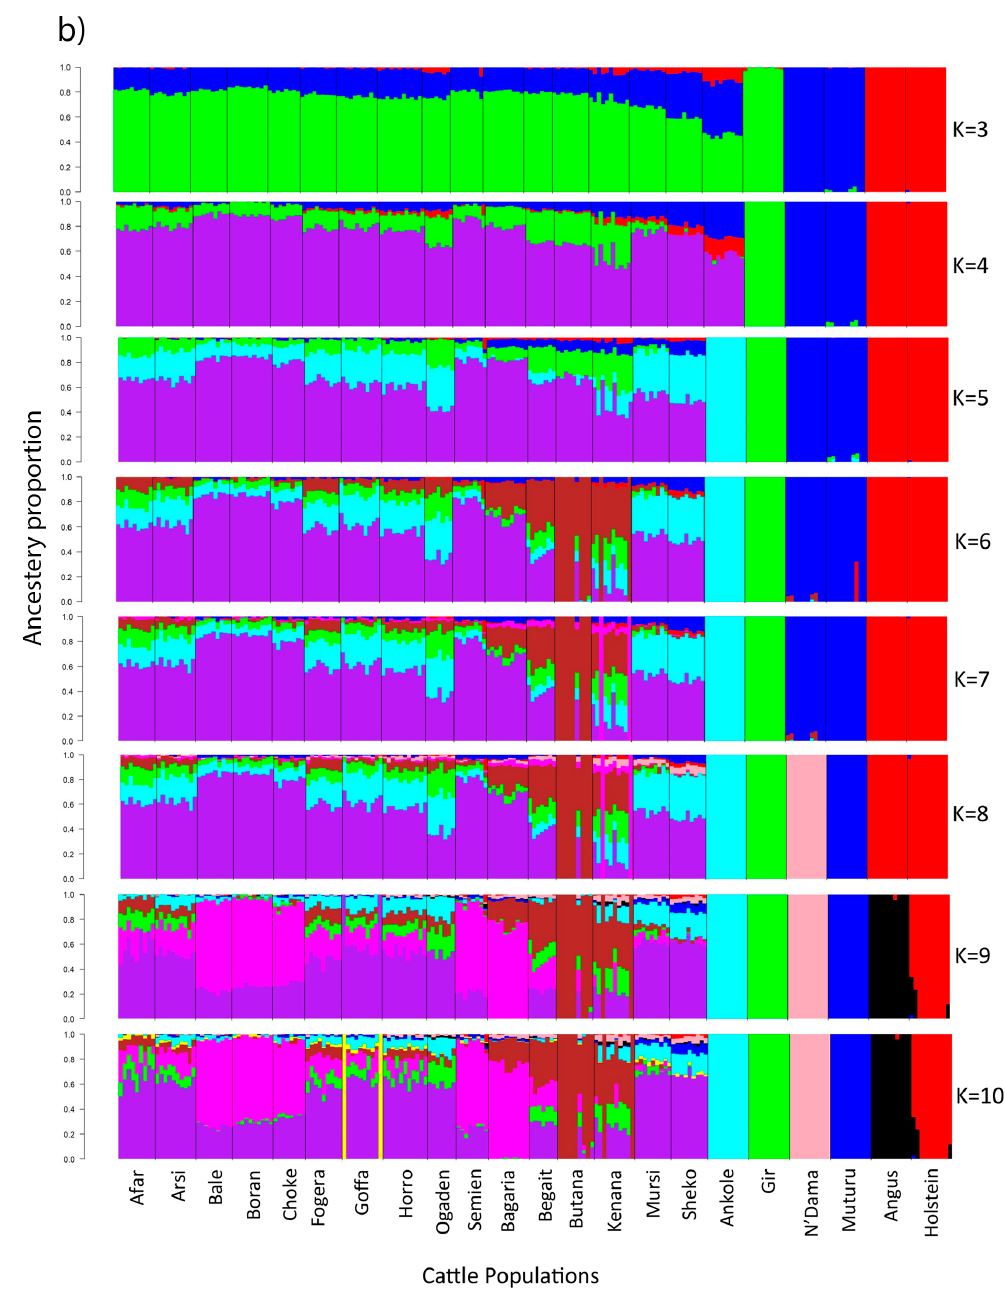
Figure 3. Admixture analysis results for all Ethiopian and non-Ethiopian cattle populations at K = 2 to 10. ( a ) Distribution of the coefficients of error variance and ( b ) ancestry proportions at K = 3 to 10. The overall population genetic differentiation ( F ST ) values between ETZ populations were lower than the values obtained between non-Ethiopian cattle populations (Table 3). Nevertheless, high F ST values were detected between Mursi and Begait (0.029), Mursi and Bagaria (0.029), Goffa and Begait (0.025), and Goffa and Bagaria (0.024), while the lowest F ST values were observed between Arsi and Horro (0.001), Semien and Choke (0.001), and Arsi and Fogera (0.002). In addition, cattle populations from the cold and humid high-altitude environment (Bale, Choke, Semien) showed low genetic differentiation (Table 3). Higher genetic differentiations were observed between ETZ and non-Ethiopian taurine breeds with F ST values ranging from 0.346 (Muturu and Bagaria) to 0.291 (Holstein and